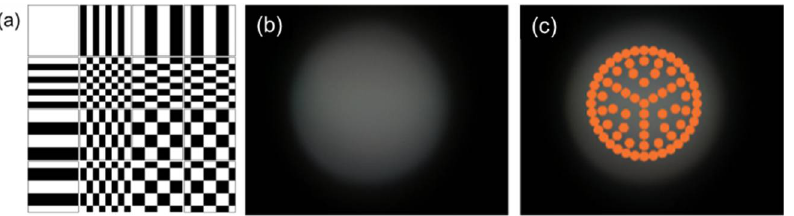
Figure 5. ( a ) Examples of the Hadamard basis patterns. ( b ) The Fourier spectrum image recorded by the detector. ( c ) The layout of the single-pixel detectors.